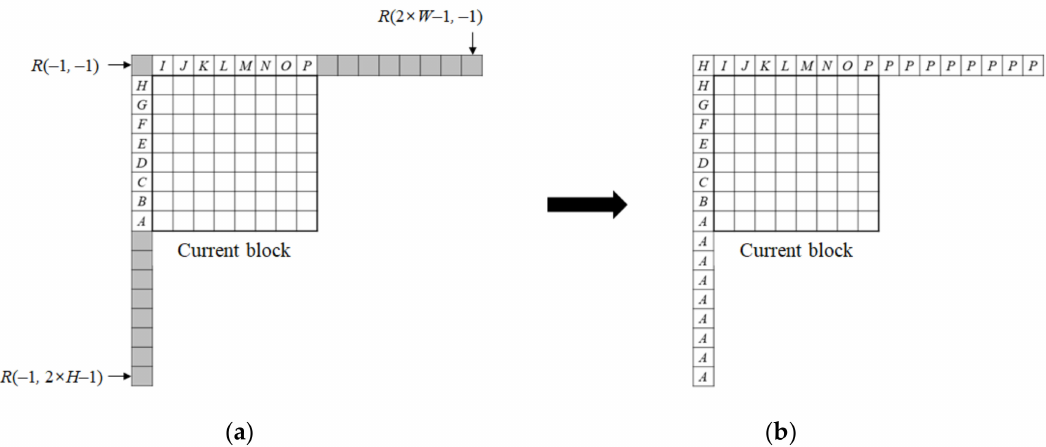
Figure 7. Neighboring sample substitution in VVC: ( a ) before the neighboring sample substitution; ( b ) after the neighboring sample